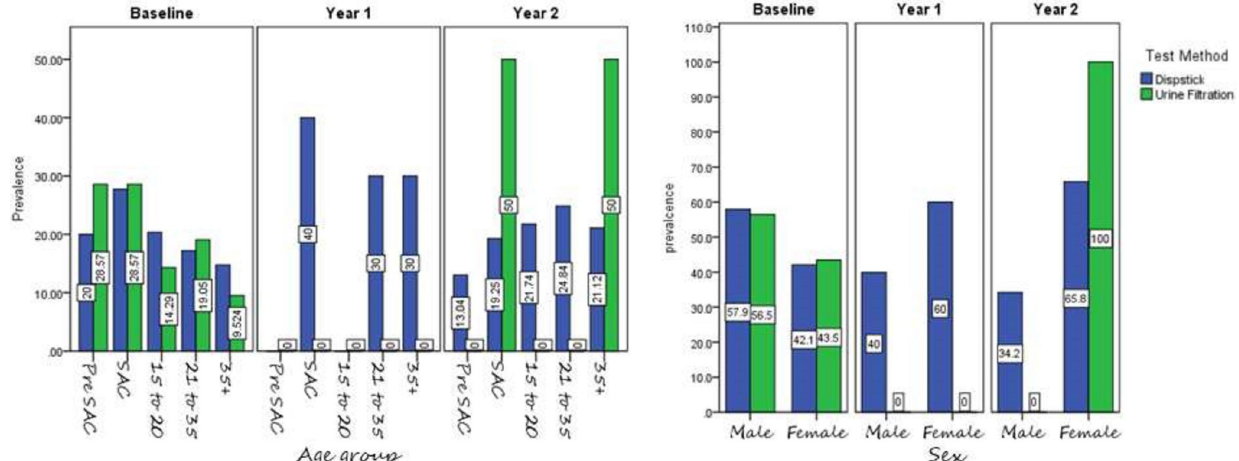
Fig 2. Prevalence of microhaematuria and S haematobium by study phase age category (left panel and sex (right panel).